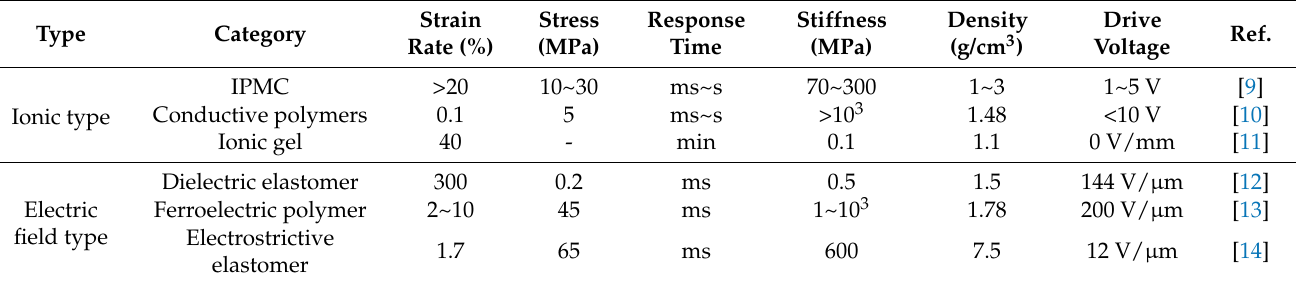
Table 2. Performance comparison of different types of EAP